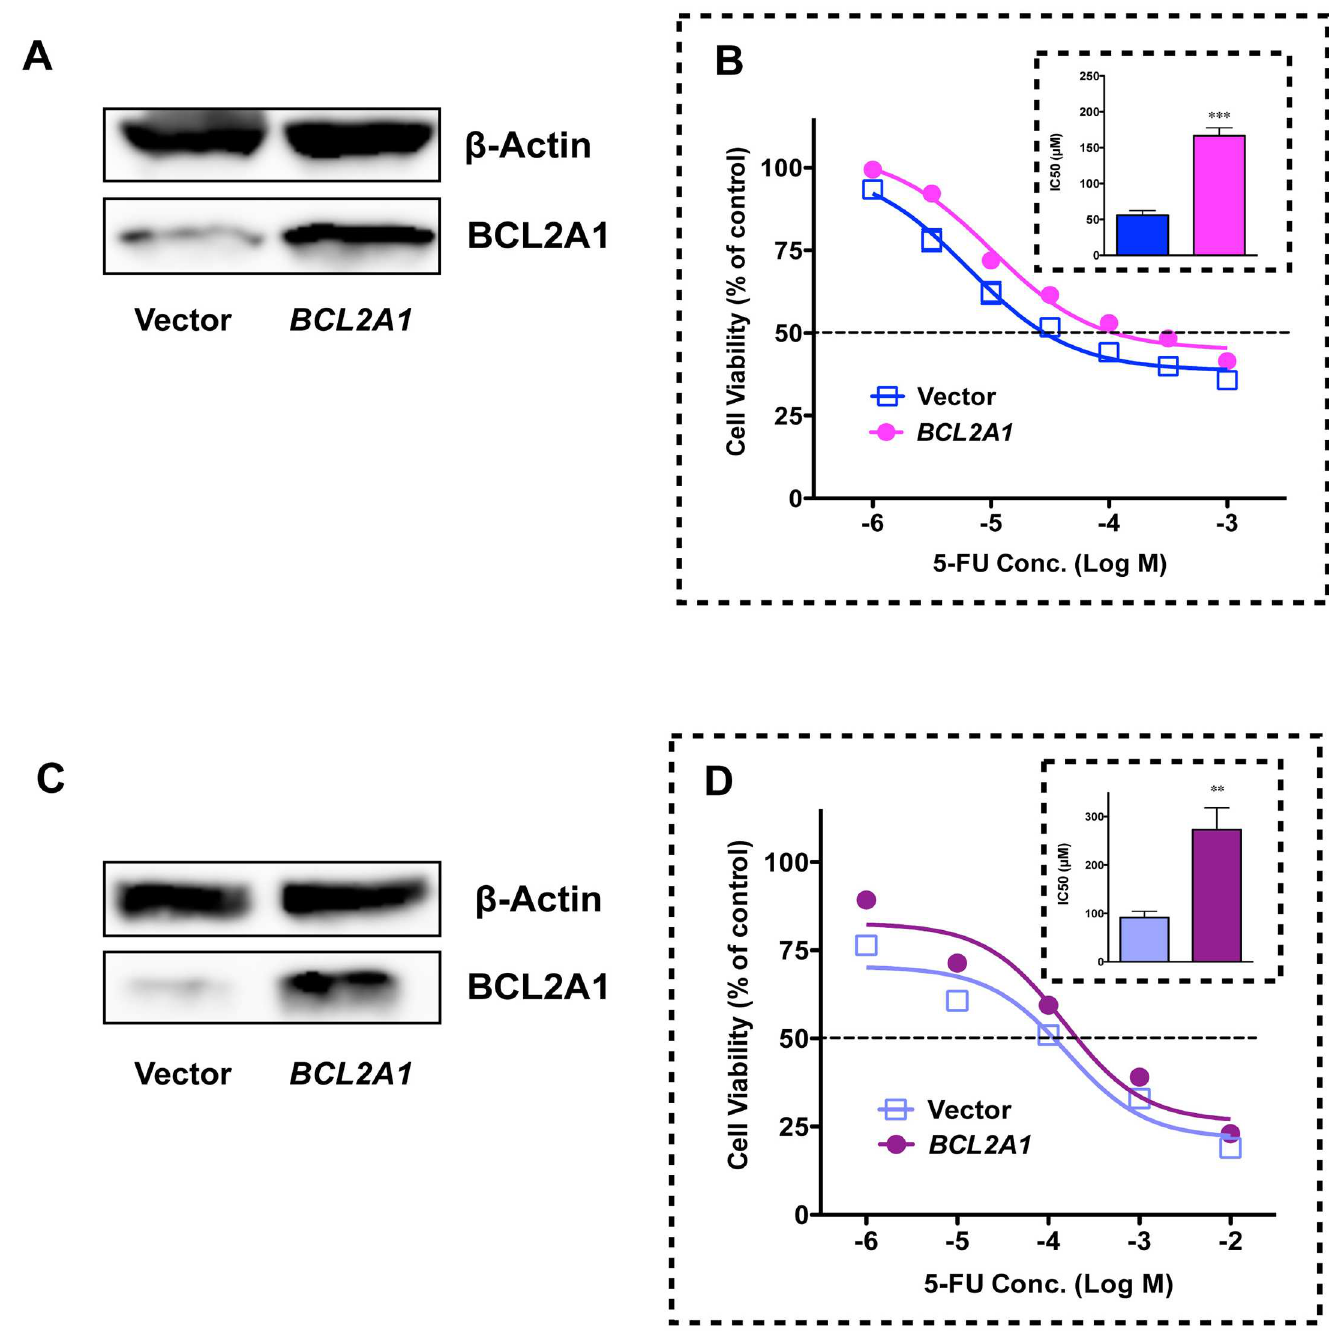
Fig 8. Effect of BCL2A1 overexpression on 5-FU-resistance in MDA-MB-231 and T-47D. BCL2A1 protein expressionof (A) MDA-MB-231 and (C) T-47D after transfection with a pCMV-Myc-DDK Entry vector (Vector) or a pCMV-Myc-DDK BCL2A1 vector ( BCL2A1 ). Cytotoxicity of 5-FU toward (B) MDA-MB-231 transfected with a BCL2A1 vector and (D) T-47D transfected with a BCL2A1 vector. The insets show the IC 50 of 5-FU against cell lines transfected with vectors. Data represent the mean with SEM of at least three independent samples ( *** p < 0.001 vs . MDA-MB-231 transfected with a control vector; * p < 0.05 vs . T-47D transfected with a control vector).